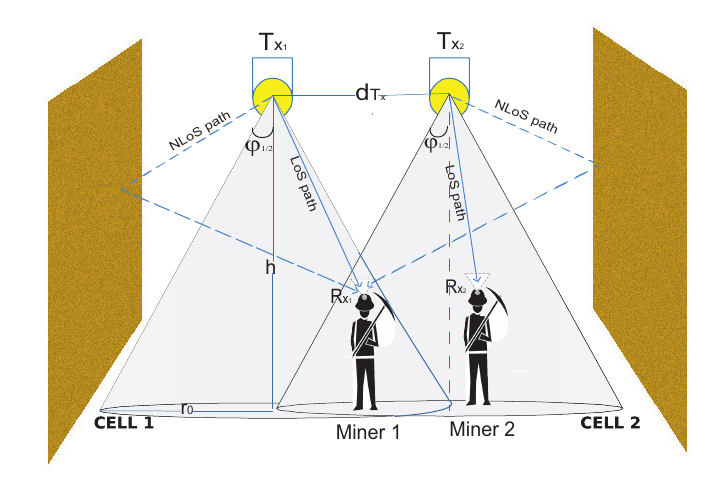
Figure 4. ICI presented in a multi-cell VLC